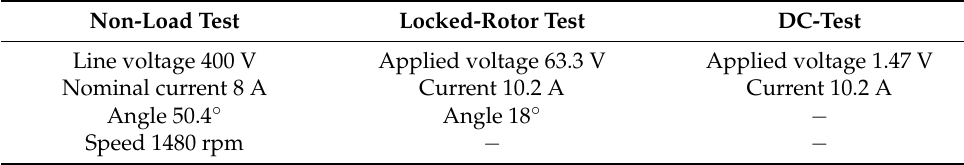
Table 5. Obtained values through tests on the three-phase IM.